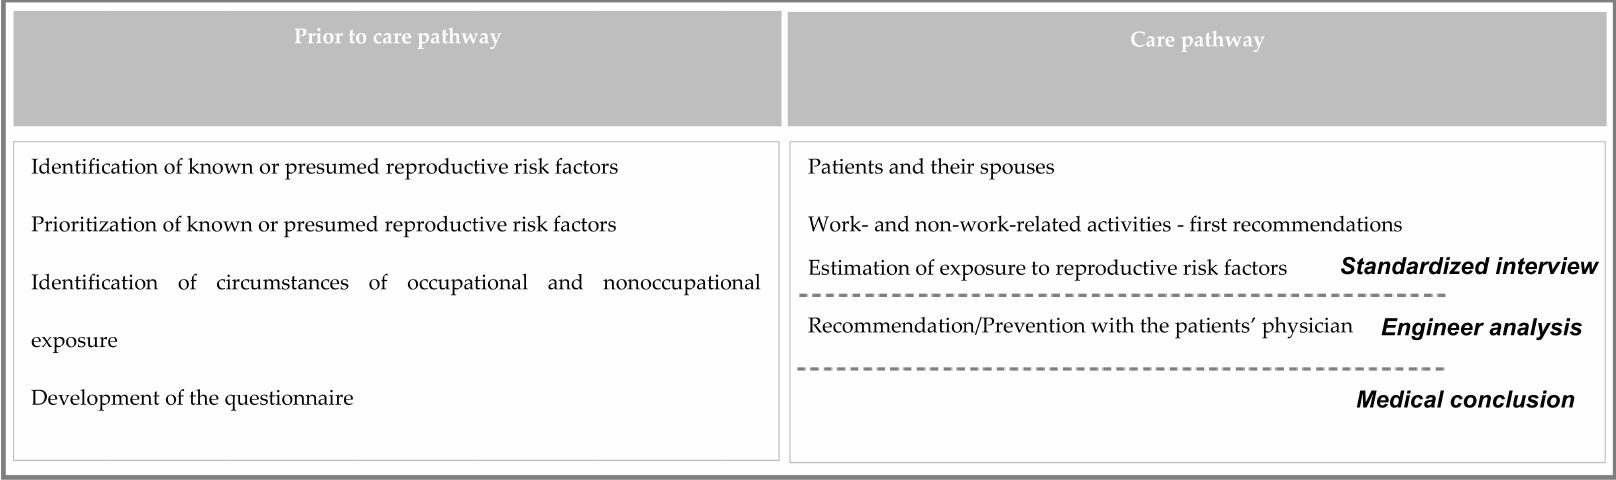
Figure 1. Measures implemented at the ARTEMIS